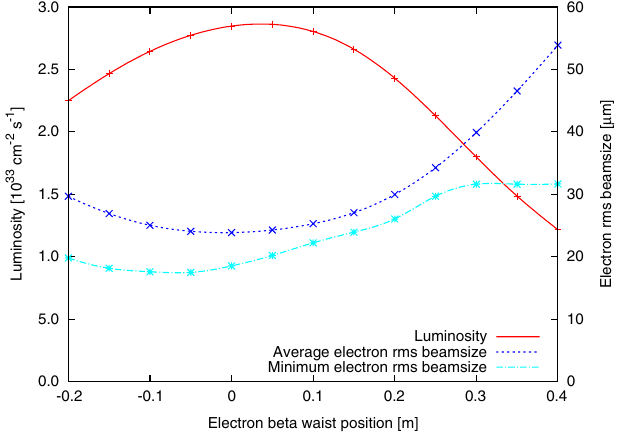
FIG. 14. (Color) Dependence of luminosity and the electron beam size as a function of s (cid:5)